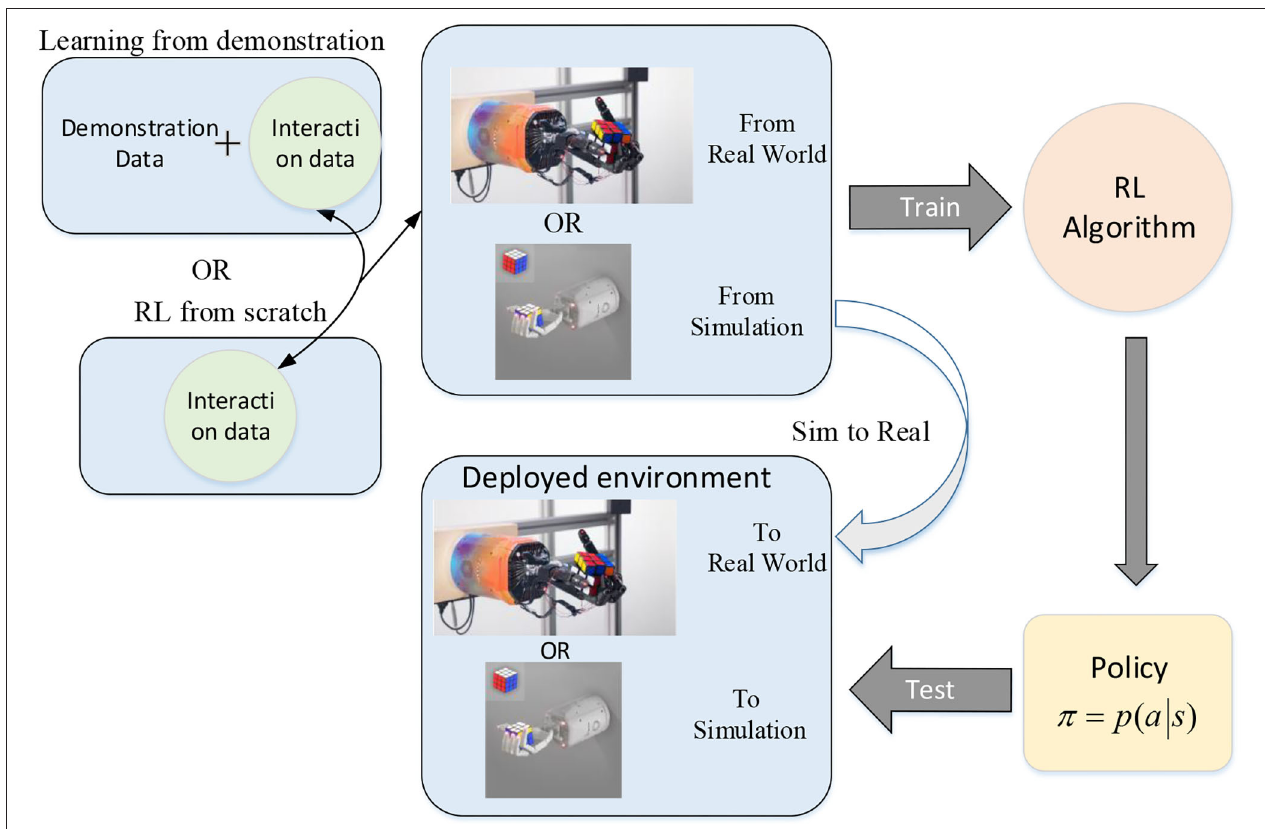
FIGURE 4 | Dexterous manipulation with a multi-fingered hand through reinforcement learning (part of this picture comes from [89]).